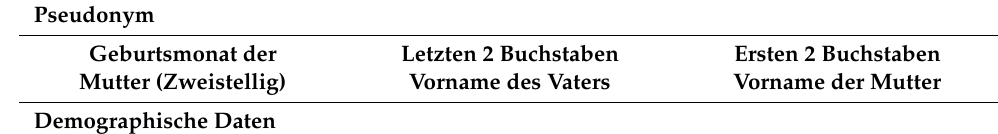
Table A1. Online questionnaire (original German